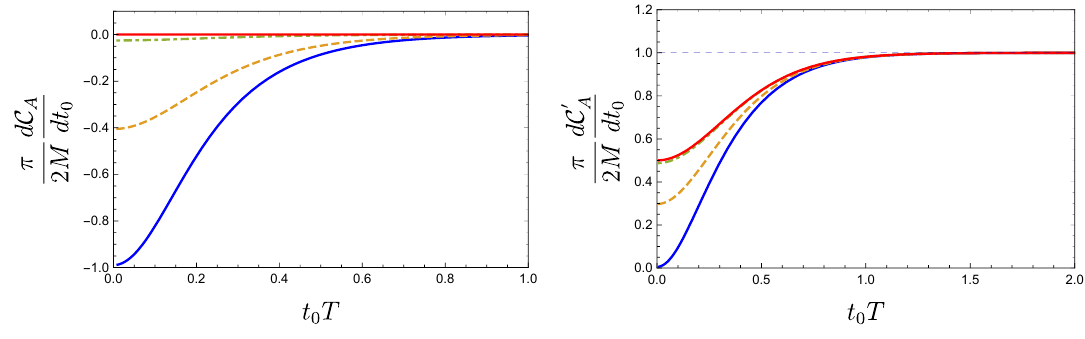
Figure 3 . The growth rate for the complexity, evaluated without (left) and with (right) the boundary counterterm in d = 2. In both plots we have the collapse from Neveu-Schwarz vacuum (i.e., k = +1) with temperatures LT = 0 : 16 (blue, solid), LT = 0 : 25 (orange dashed) and LT = 1 : 0 (green dot-dashed). The collapse from Ramond vacuum (i.e., k = 0) is shown in red. For the NS vacuum, the growth rate always starts at di(cid:11)erent values for di(cid:11)erent temperatures, as given by eq. (3.53) (left) and eq. (3.56) (right). In both cases, the high temperature limit of the NS collapse approaches the Ramond collapse. At late times, independent of the temperature, the rate of change approaches zero on the left, and 2 M=(cid:25) on the